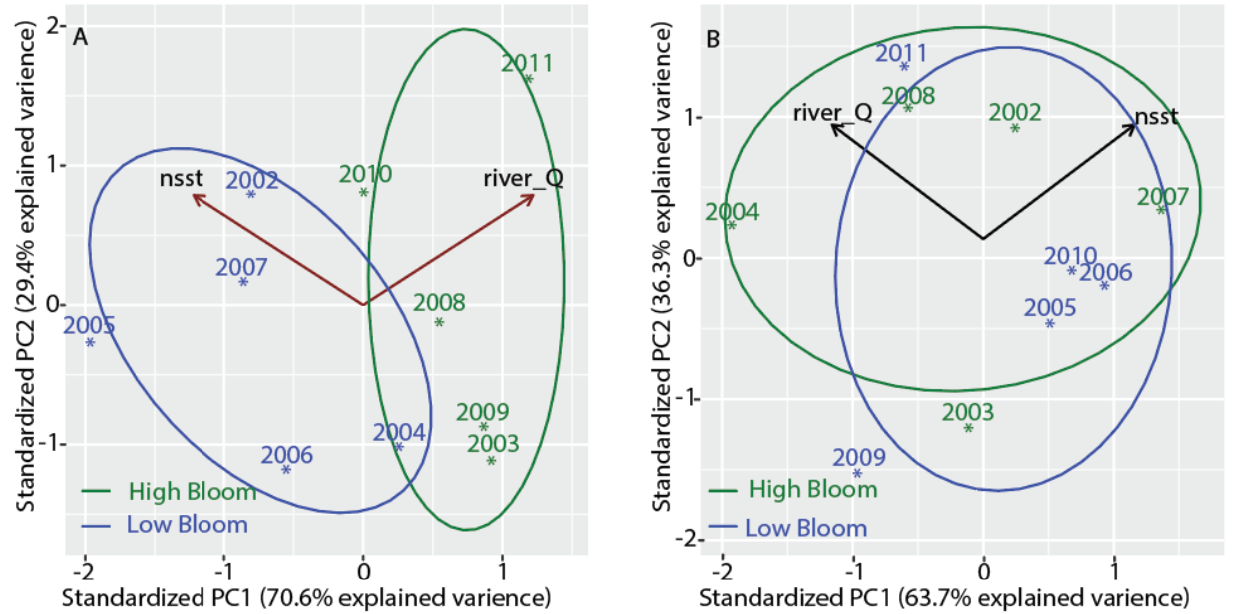
Figure 10. Principal Components Analysis (PCA) by year (2002 – 2011) for the separation between the top five bloom years (high bloom) and bottom five bloom years (low bloom) for 2003 – 2011 using best models for western Lake Erie. Three-parameter PCA for western Lake Erie ( A ) and Green Bay ( B ) showing the separation between high (green) and low (blue) bloom years. The two input parameters were river discharge (river_Q) and night time sea surface temperature (nsst) as having been identified as drivers for blooms in western Lake Erie.